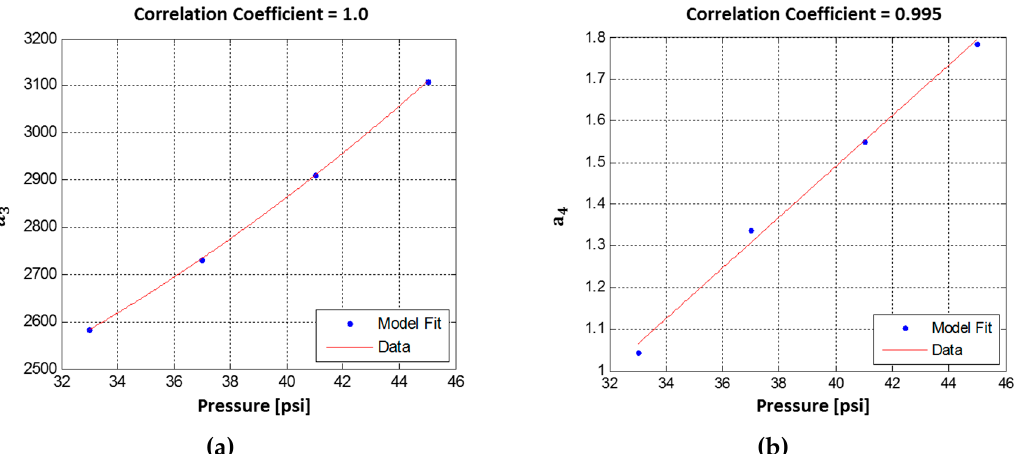
Figure 17. Model fitting results. ( a ) ‘a3’ pressure adaptation, ( b ) ‘a4’ pressure adaptation.